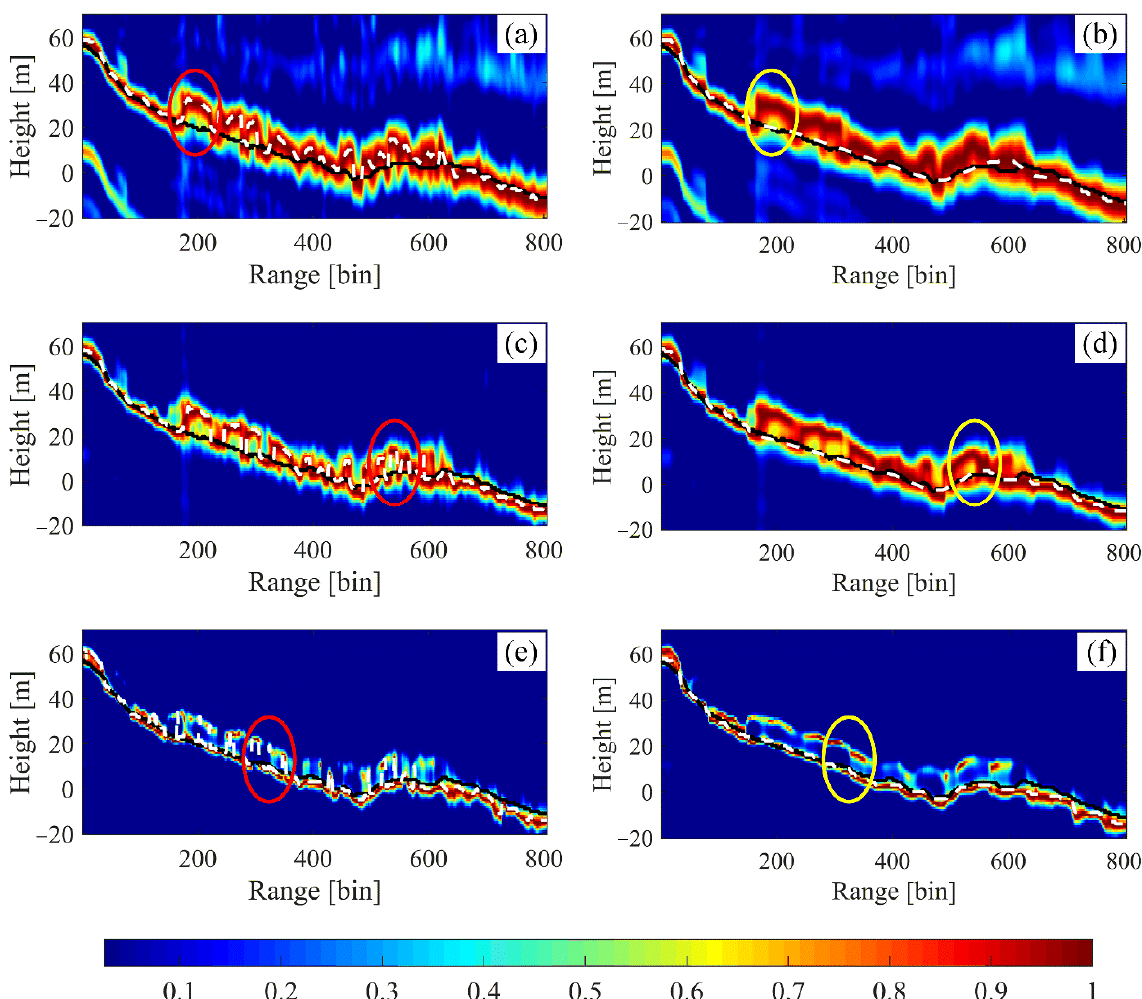
Figure 4. Tomograms of the HH polarization channel at the selected profile estimated by the different TomoSAR methods: ( a ), ( c ), ( e ) are, respectively, the results of local means (LM)-based beamforming, adaptive beamforming (Capon), and multiple signal classification (MUSIC); and ( b ), ( d ), ( f ) are the results of NLM-based beamforming, Capon, and MUSIC, respectively. The solid black line is the LiDAR DTM, and the dashed white line is the estimated values.